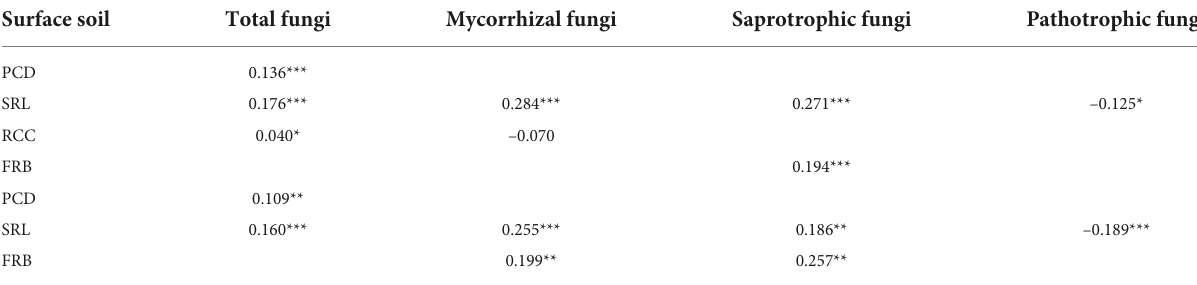
TABLE 2 Relationships between root attributes and β -deviations of total, mycorrhizal and saprotrophic and pathotrophic fungi in surface and subsurface soil. Surface soil Total fungi Mycorrhizal fungi Saprotrophic